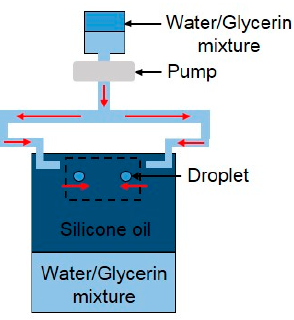
Figure 7. Schematic of flow facility for binary droplet collision in water–glycerin mixture.